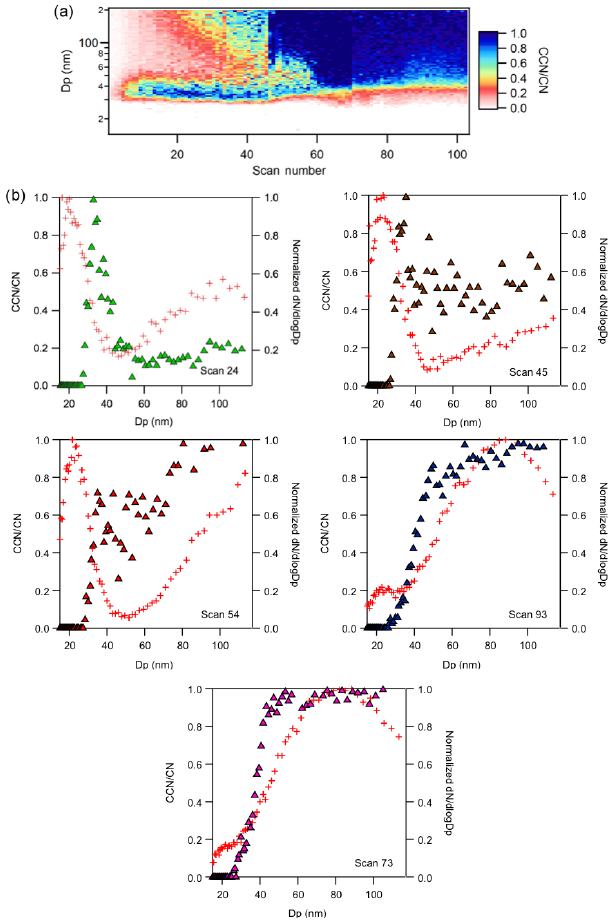
Figure 9. (a) Time series of CCN / CN activated fractions of suc- cinic acid (SA) and combustion aerosol (BC) mixture in flow tube. (b) The CCN / CN activated fraction (closed triangles) of SA and BC mixtures for particle distribution scans 24, 45, 54, 73, and 94. Aerosol water is introduced at ∼ scan 70 to promote internal mix- ing. Cross symbols show the particle size distribution of mixed